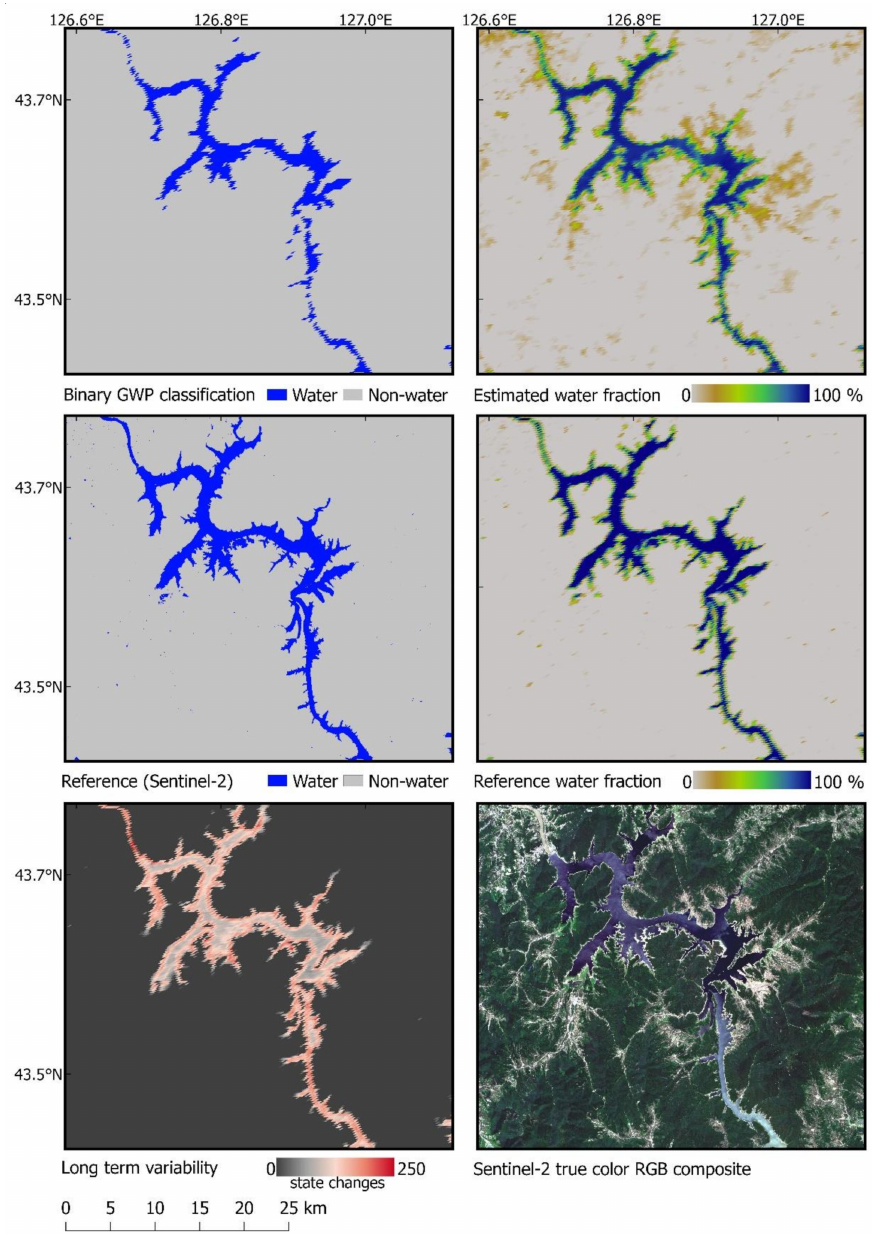
Figure 12. Comparison of original GWP binary classification, estimated water fraction and reference water fraction based on Sentinel-2 for Songhua Lake and River (China) on 2019-07-10. Water variabil- ity refers to the 10-year time-series of MODIS tile h27v04 and illustrates typical extent